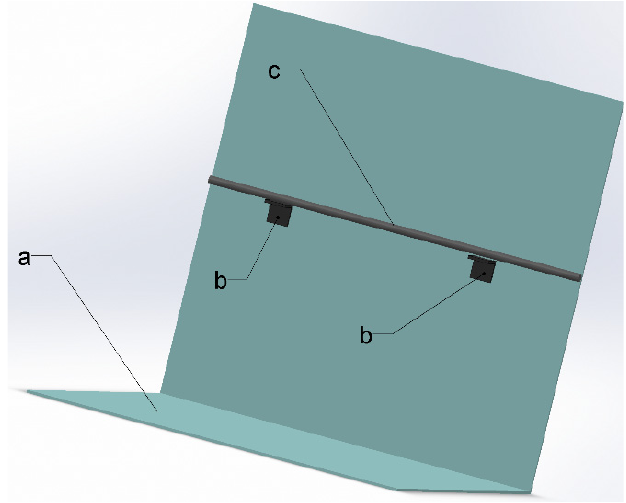
Figure 4. Partial illustration of the cable harness assembly example with (a) a cutaway view of the main structure, (b) brackets holding a cable, and (c) an electrical cable; modified from [20].